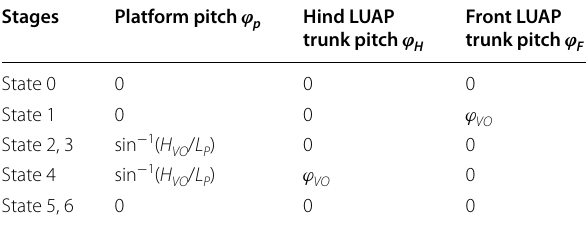
Table 3 Vertical obstacle surmounting parameters